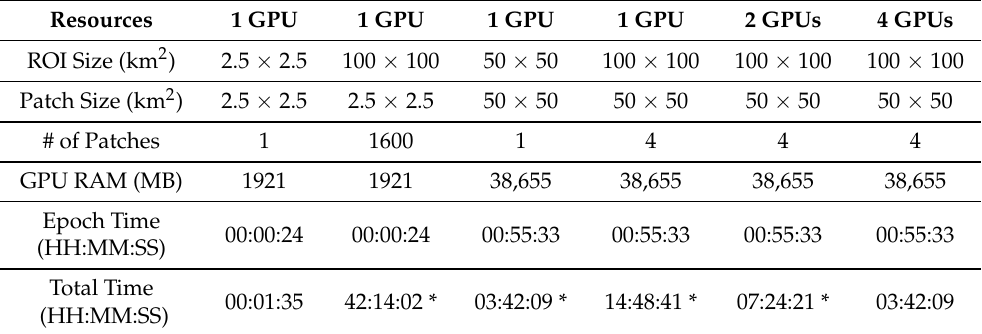
Table A1. The time and memory usage of the proposed technique. For 4 GPUs independently processing segmented patches, a tile as large as 100 km by 100 km can be processed in under 4